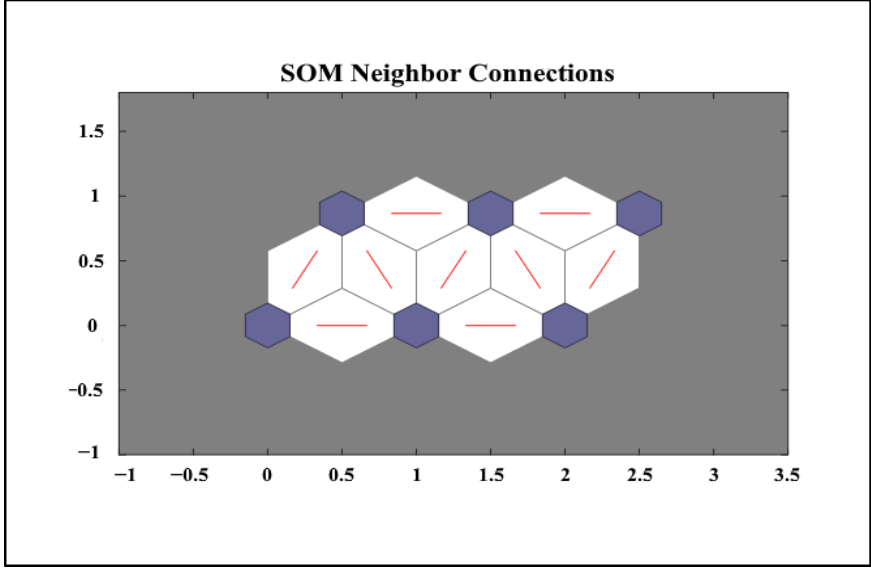
Figure 4. Neighborly connections between clusters.